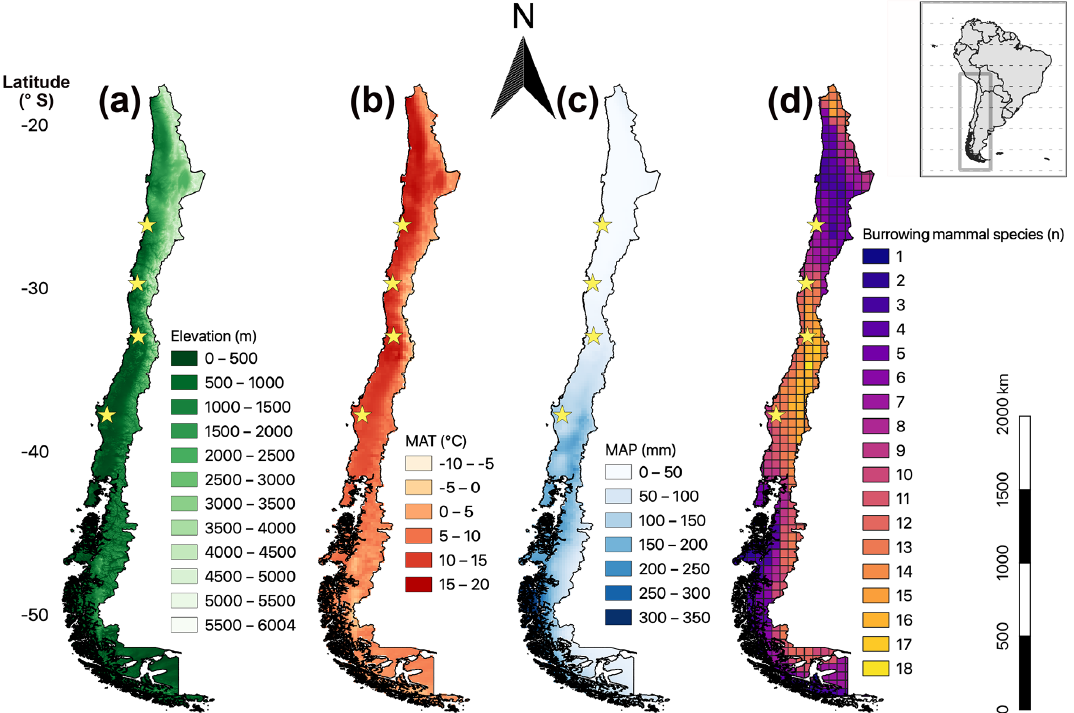
Figure 1. Map of mainland Chile showing four parameters: (a) elevation; (b) mean annual temperature (MAT); (c) mean annual precipitation (MAP), MAT, and MAP from Fick and Hijmans (2017); (d) distribution of burrowing mammal species; in map (d) the grid size is 0.5 latitudinal degrees (approx. 55km × 55km side lengths). The database for the depicted number of mammal species contains distributional polygons of 40 species (International Union for Conservation of Nature (IUCN) Red List of Threatened Species), downloaded from the web page October 2018; stars: field sites of this study; black edging: border of Chilean mainland and shore (with many small islands in the